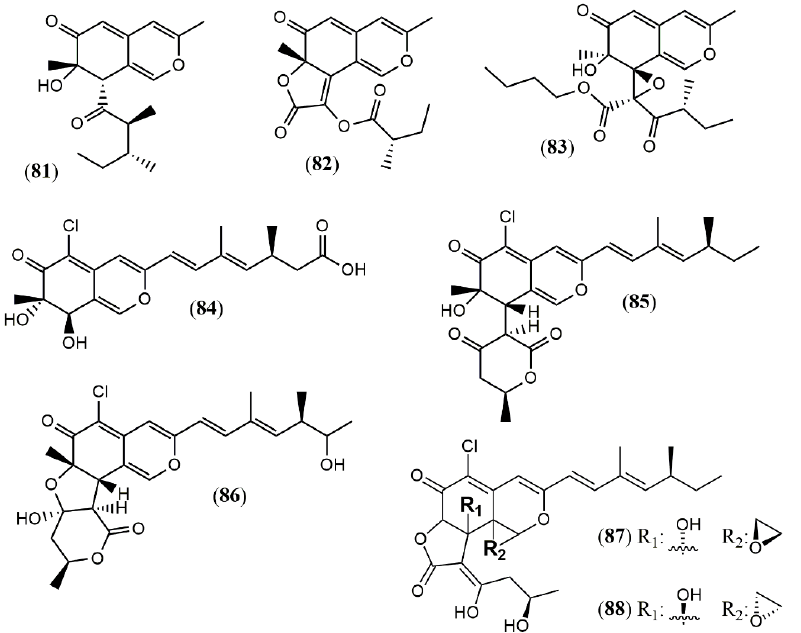
Figure 7. Chemical structures of azaphilones from Phomopsis : 81–83 : phomopsones A–C; 84–88 : tersaphilones A–E [55,56].